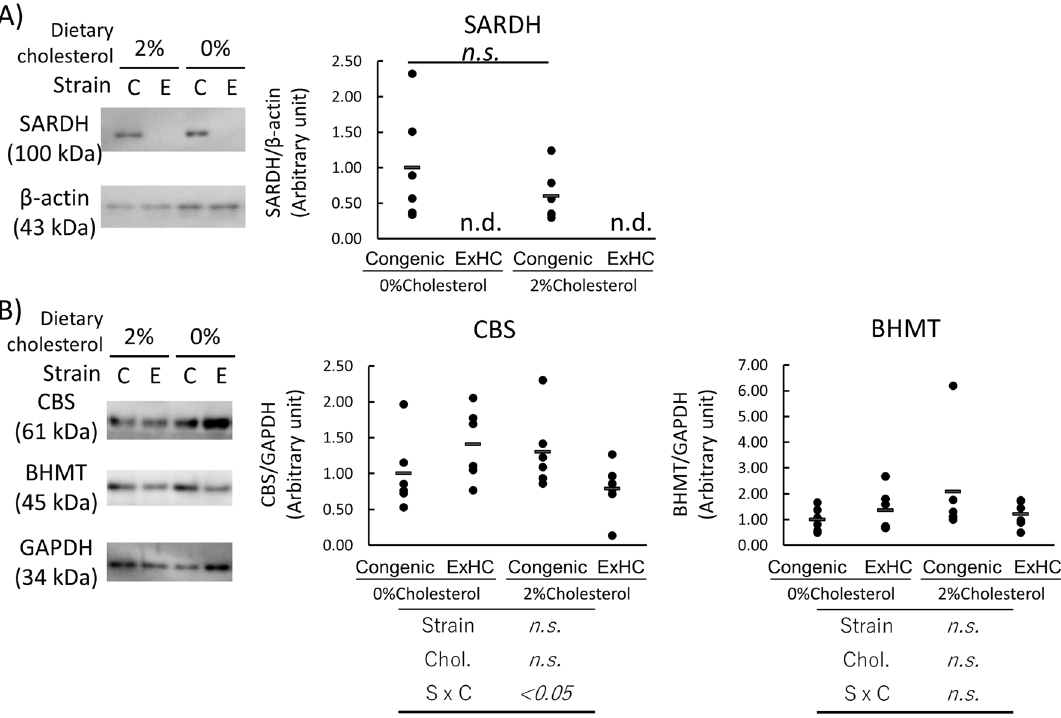
Figure 1. Protein expressions in the livers of congenic (ExHC.BN- Dihc2 BN ) (C) and ExHC (E) rats. ( A ) SARDH, ( B ) CBS and BHMT. n = 6/group, Dots and bar in each graph represent the values of each rats and the average of group, respectively. Differences among groups were analyzed with two-way ANOVA with Tukey– Kramer post-hoc test. n.d.; not detected, n.s.; not significant.